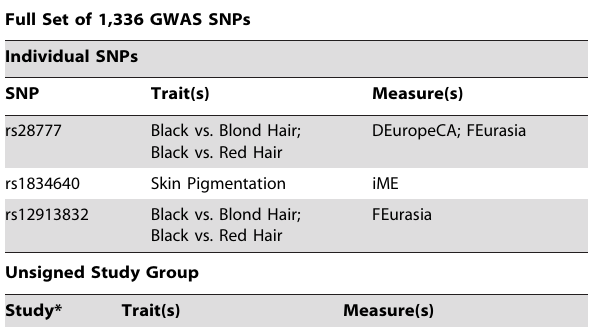
Table 3. Individual SNPs and study groups that were significant for at least one Delta, F st , LLC, or iHS measure in the individual SNP, group unsigned, or group signed analysis of all 1,336 GWAS SNPs.